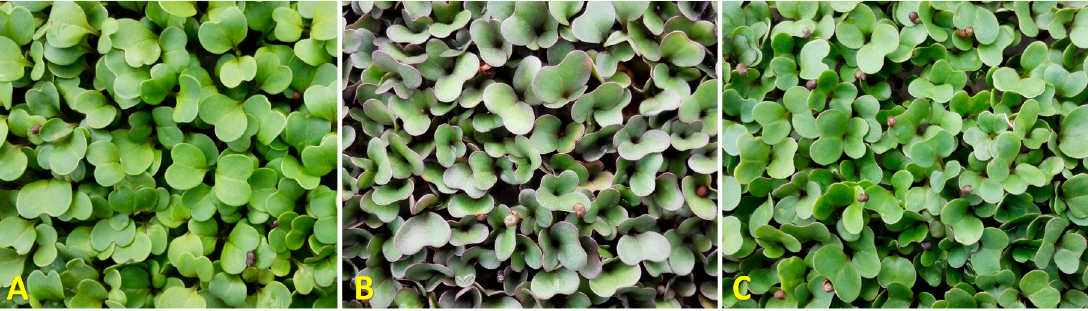
Figure 1. Brassica microgreens from the project: broccoli raab ( A ); cauliflower ( B ); broccoli ( C ).